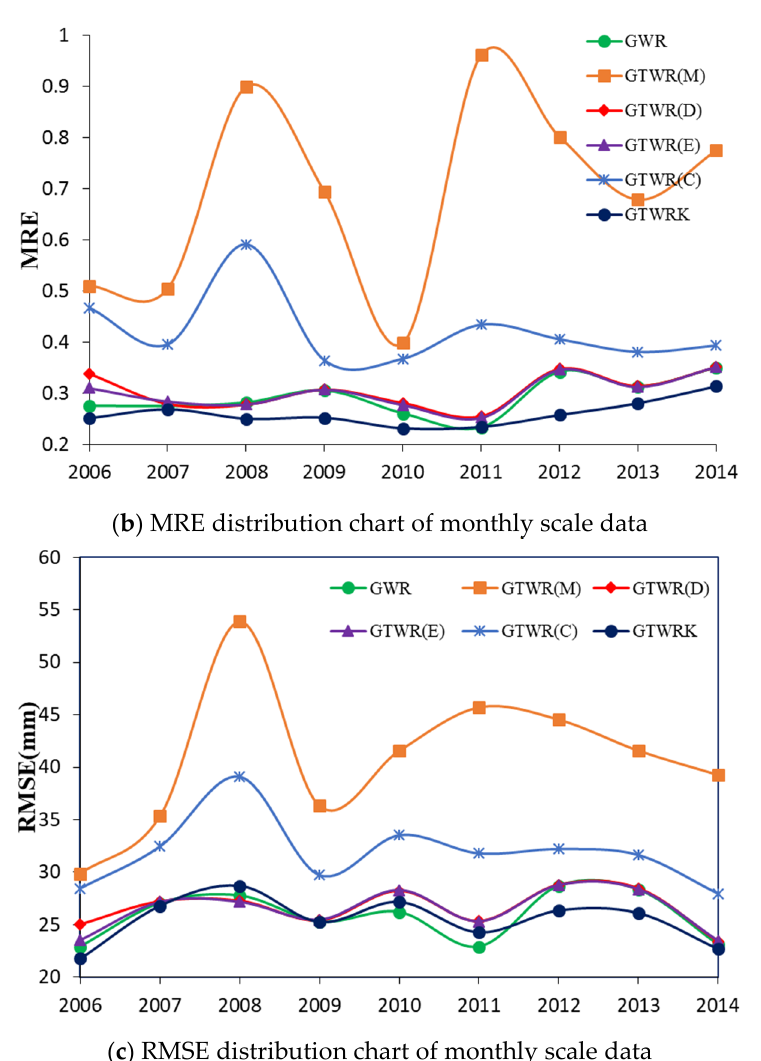
Figure 6. The average error maps for monthly scale data from 2006 through 2014. ( a – c ) represent the average distribution chart of mean average error (MAE), mean root error (MRE), and root mean square error (RMSE), respectively.